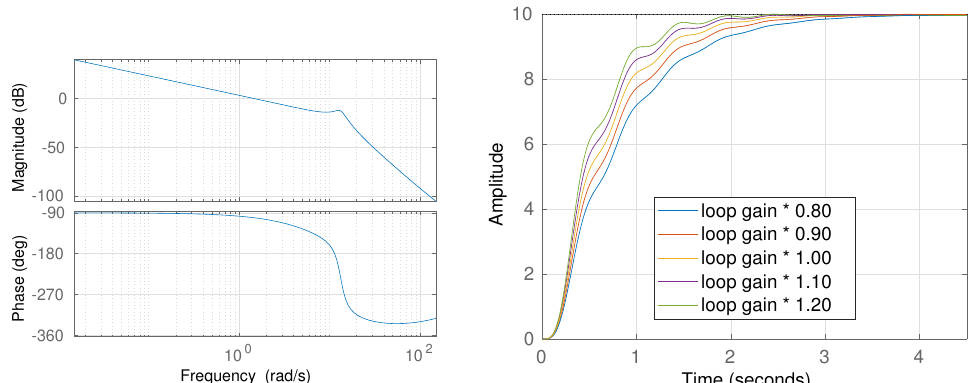
Figure 8. Frequency response ( left ) and time response ( right ) for the integer order controller system.